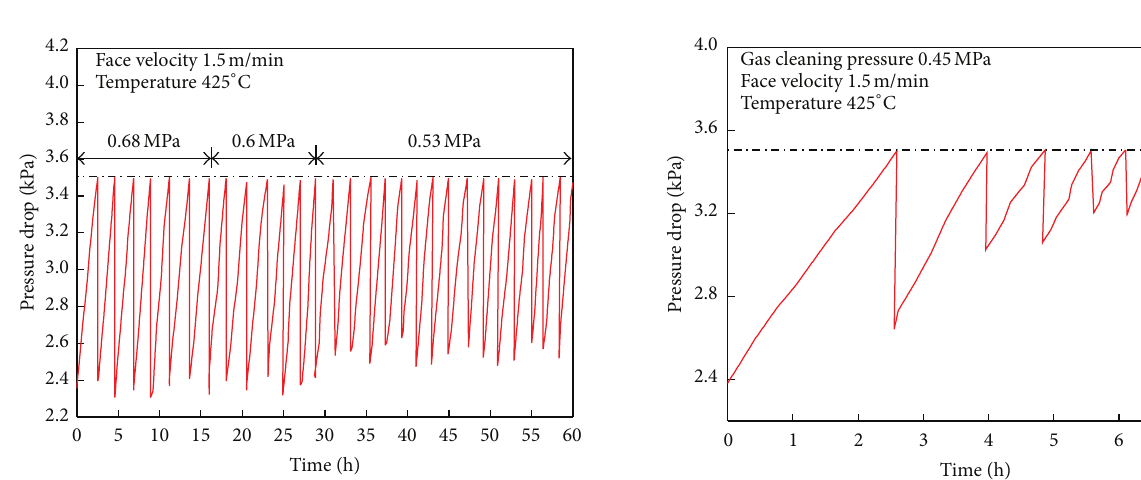
Figure 15: Pressure drop variations for gas cleaning pressure of 0.45 MPa.